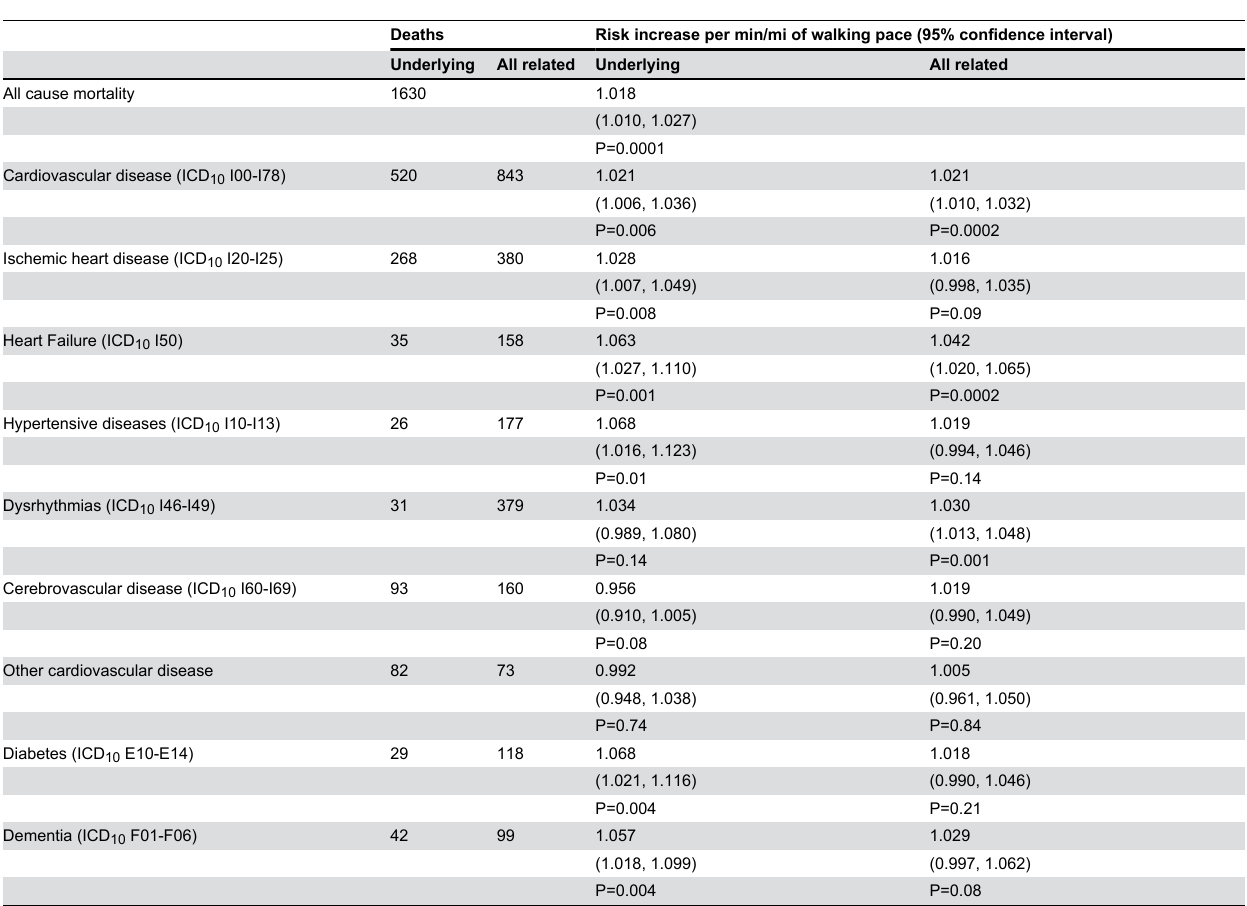
Table 4. Effects of excluding deaths occurring within the first three years since baseline on the hazard ratios of all-cause